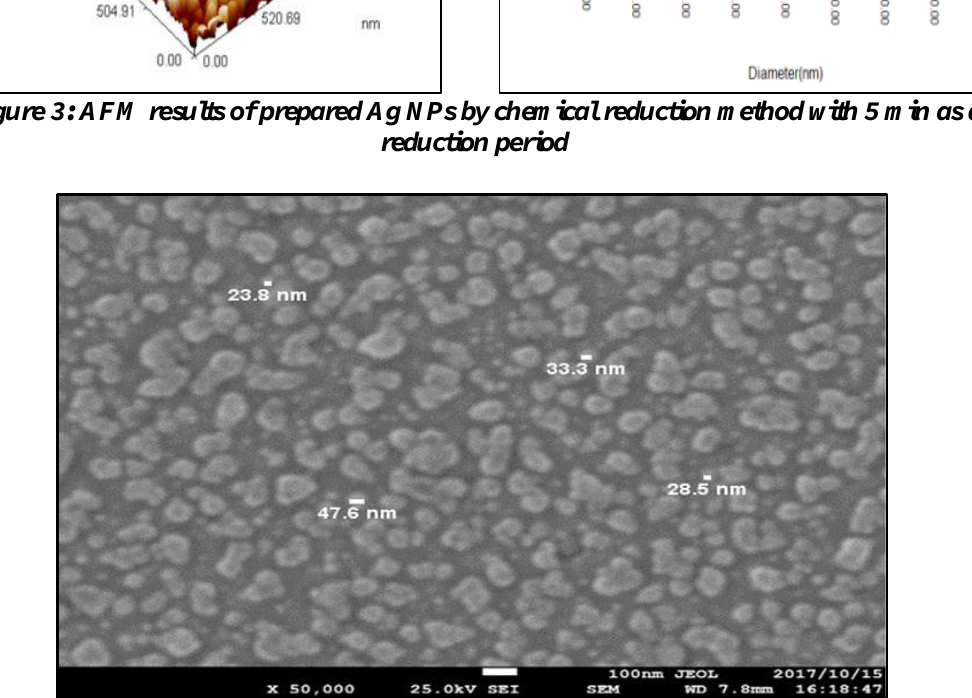
Figure 4: FE-SEM image with magnification force = 50 kx of prepared Ag NPs by